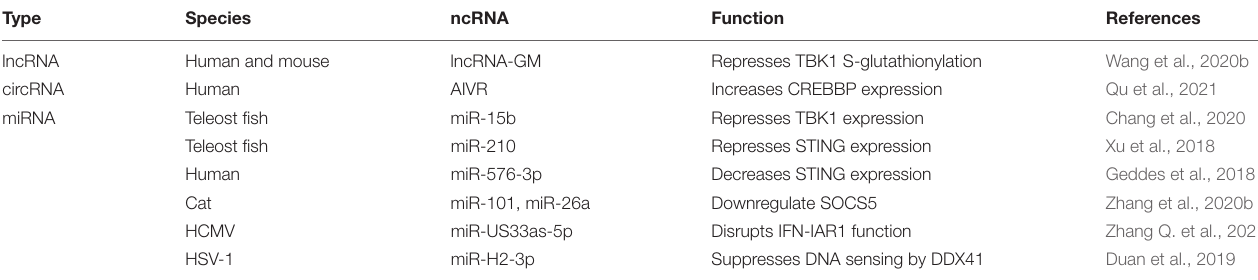
TABLE 6 | Regulations of non-coding RNA in virus